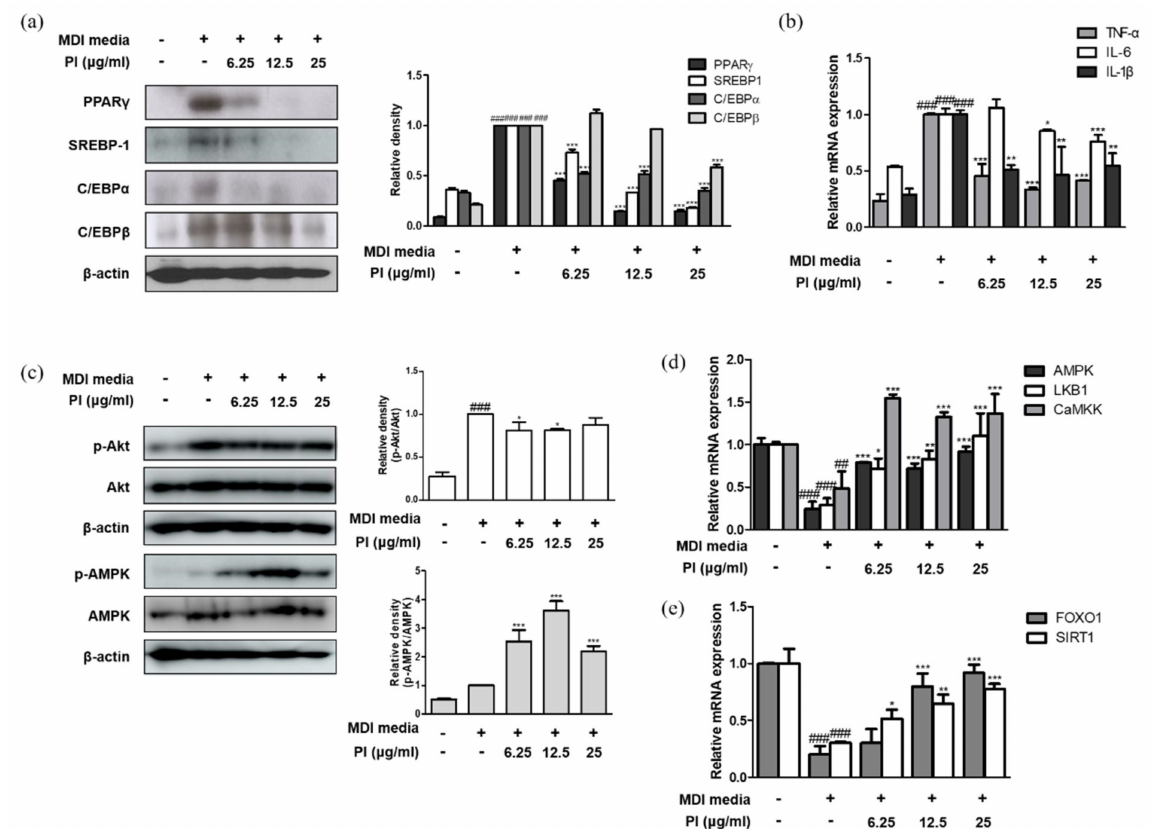
Figure 7. Effects of papain on inflammatory and adipogenic factors in MDI–treated 3T3–L1 preadipocytes. ( a ) Protein expressions of PPAR γ , SREBP–1, C/EBP α and C/EBP β were determined by western blot analysis with specific antibodies. β –actin was used as internal controls. ( b ) The mRNA levels of TNF– α , IL–6, and IL–1 β were determined by qRT–PCR. ( c ) Protein expressions of p–AMPK and AMPK were determined by western blot analysis with specific antibodies. β –actin was used as internal controls. The mRNA levels of ( d ) AMPK, LKB1, CaMMK, ( e ) FoxO1, and SIRT1 were determined by qRT–PCR. Densitometric analysis was performed using Bio-Rad Quantity One ® Software. The data shown represent mean ± SD of three independent experiments. ## p < 0.01, ### p < 0.001 vs. non-treated group; * p < 0.05, ** p < 0.01, *** p < 0.001 vs. MDI-treated